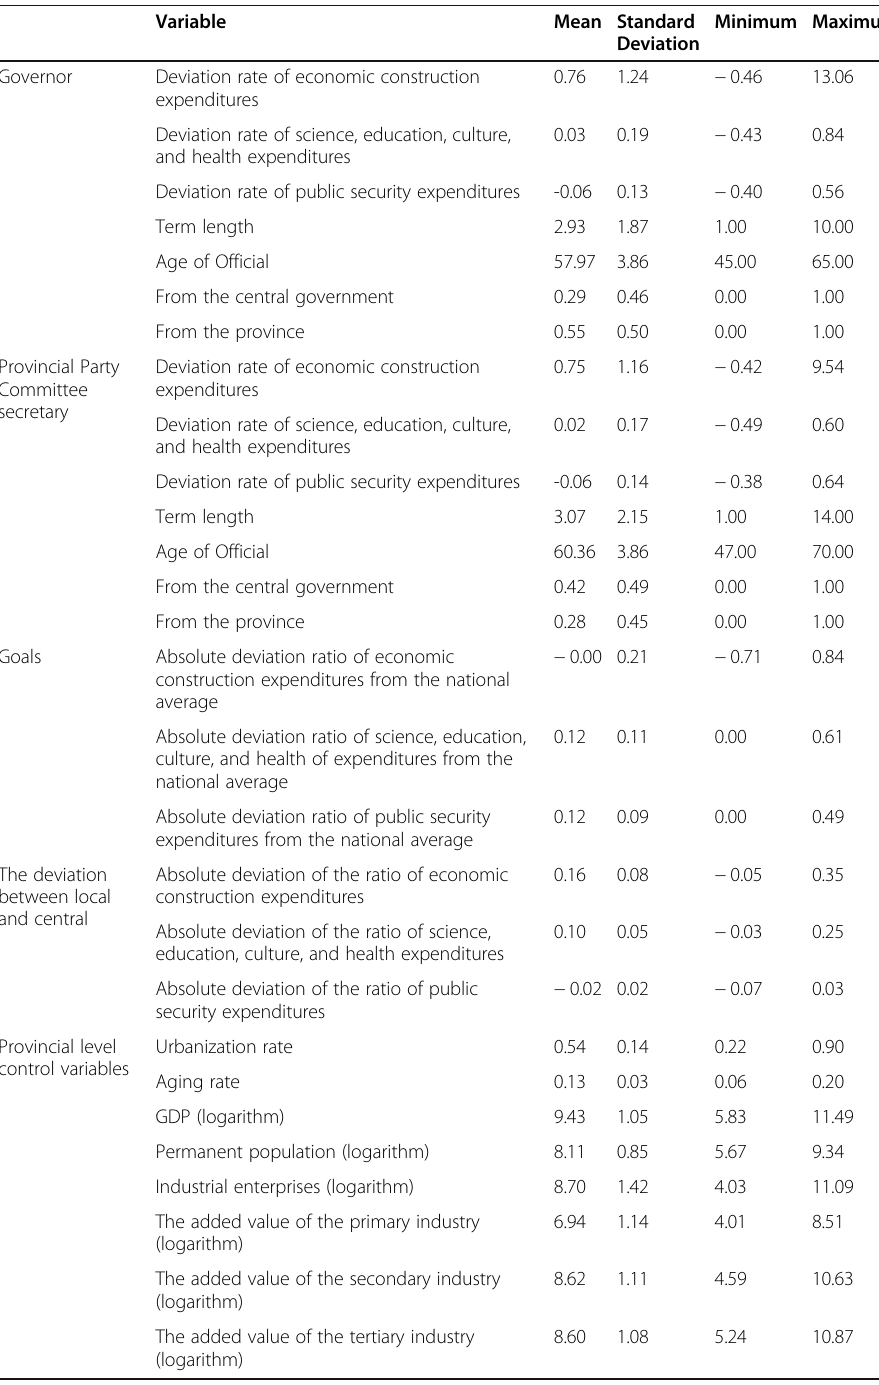
Table 1 Descriptive statistics of each